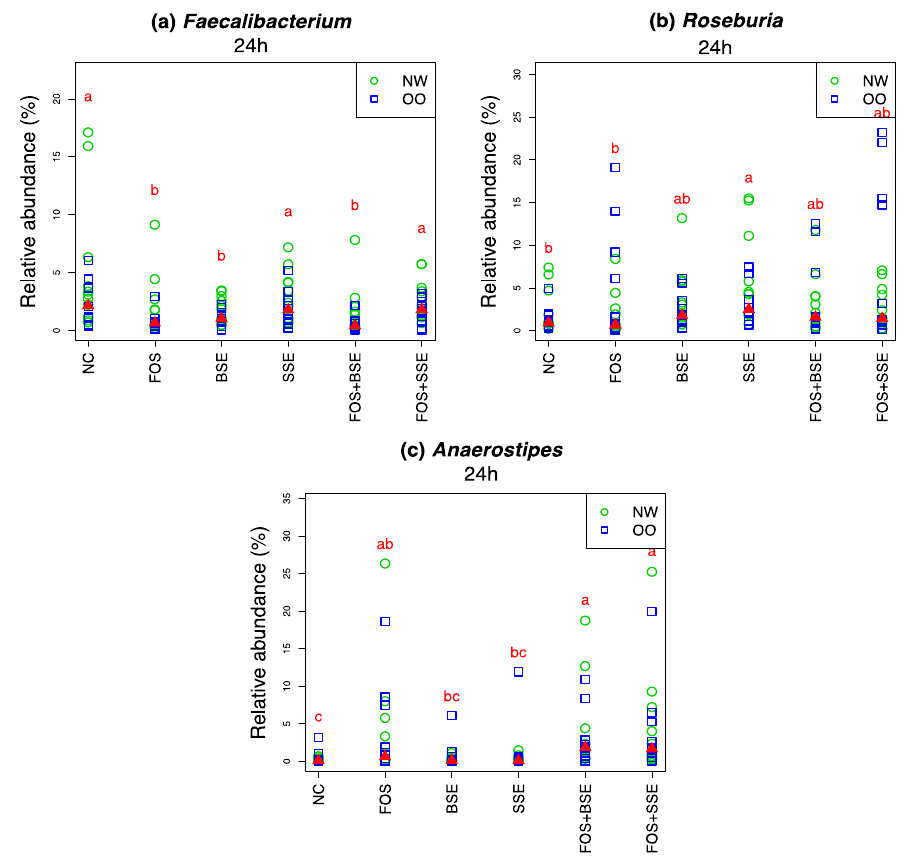
Figure 6. Relative abundance of butyric acid-producing bacteria ( n = 22). ( a ) Faecalibacterium , ( b ) Roseburia , ( c ) Anaerostipes . Letters indicate significant differences between treatments at 24 h, achieved by the Friedman test and its post hoc multiple comparisons at the 0.05 level of significance. The medians are marked with red triangles. The weight classes (NW vs. OO) are labeled by green circles and blue squares, respectively. NC: negative control, FOS: fructooligosaccharides, BSE: black sorghum bran extract, SSE: sumac sorghum bran extract.